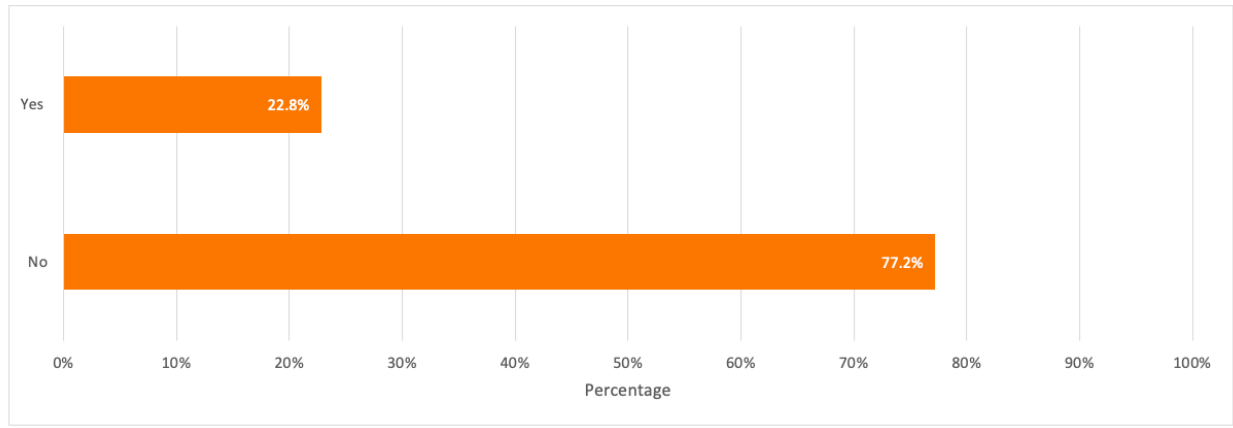
Figure 5. Respondents’ awareness of any recycling companies or centers dedicated to e -waste collection and recycling.